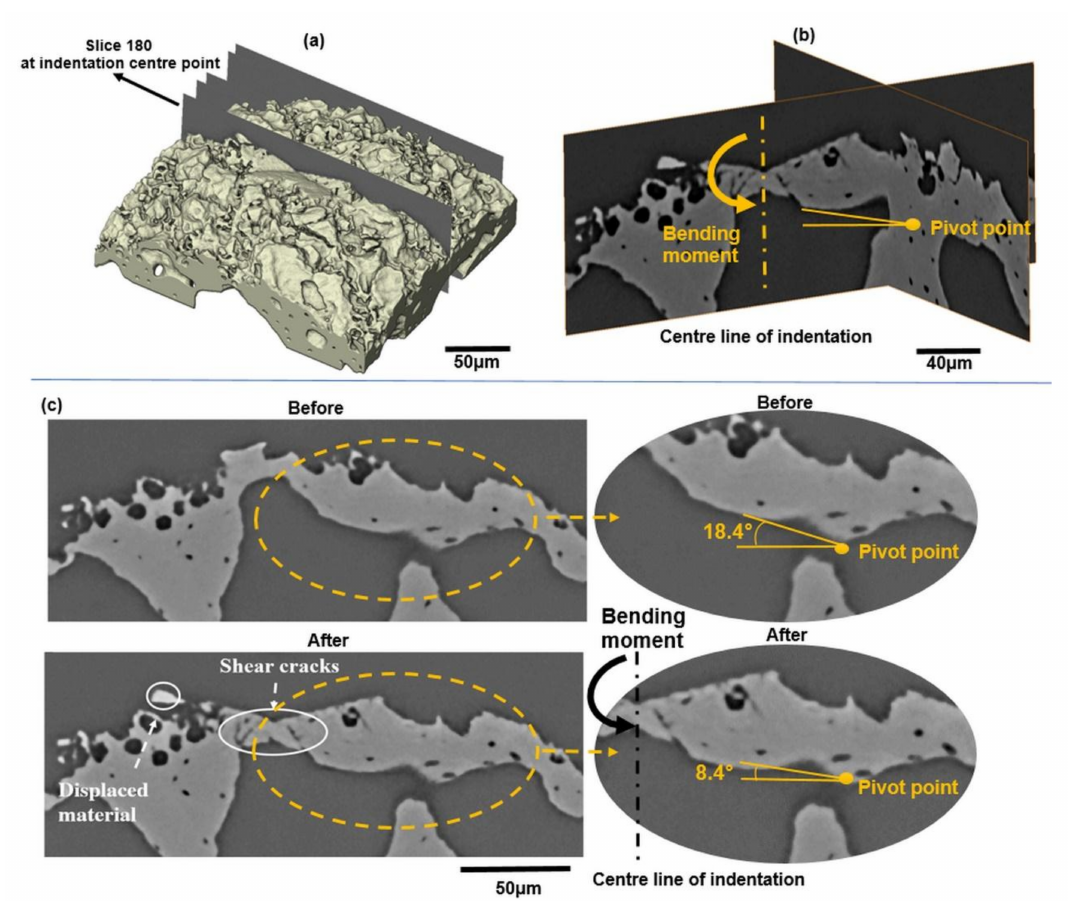
Figure 11. ( a ) Volumetric rendering of the indentation site, ( b ) Orthoslice from the other orientation showing the pivot point, ( c ) Individual slice images showing the damage immediately below the indentation tip (see also animated sequences in supplementary video